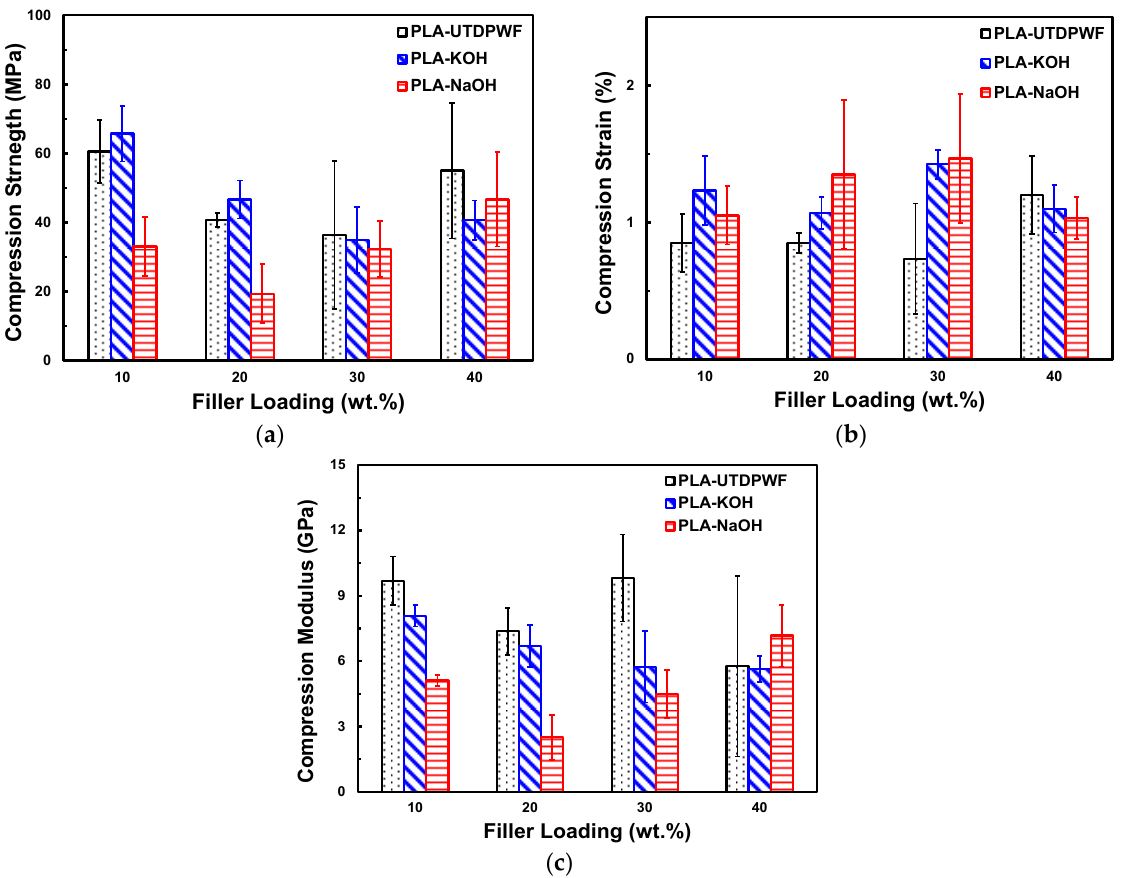
Figure 9. Compression Stress ( a ), Strain ( b ), and Modulus of Elasticity ( c ) for PLA-UTDPWF, PLA- KOH, and PLA-NaOH composites.